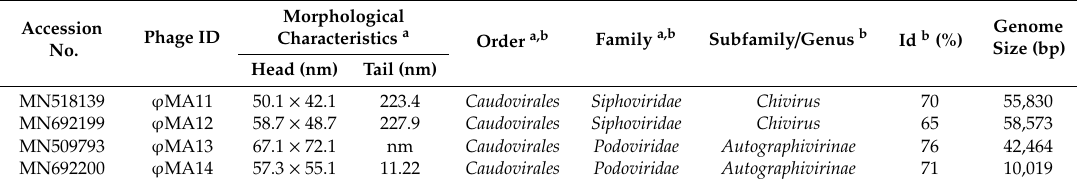
Figure 1. Transmission electron micrographs of negatively stained bacteriophages identified in this study from the order Caudovirales belonging to two families of Podoviridae ( A ) ϕ MA13; ( B ) ϕ MA14; and Siphoviridae ( C ) ϕ MA12 ( D ) ϕ MA11. Table 2. Characteristics of bacteriophages isolated in this